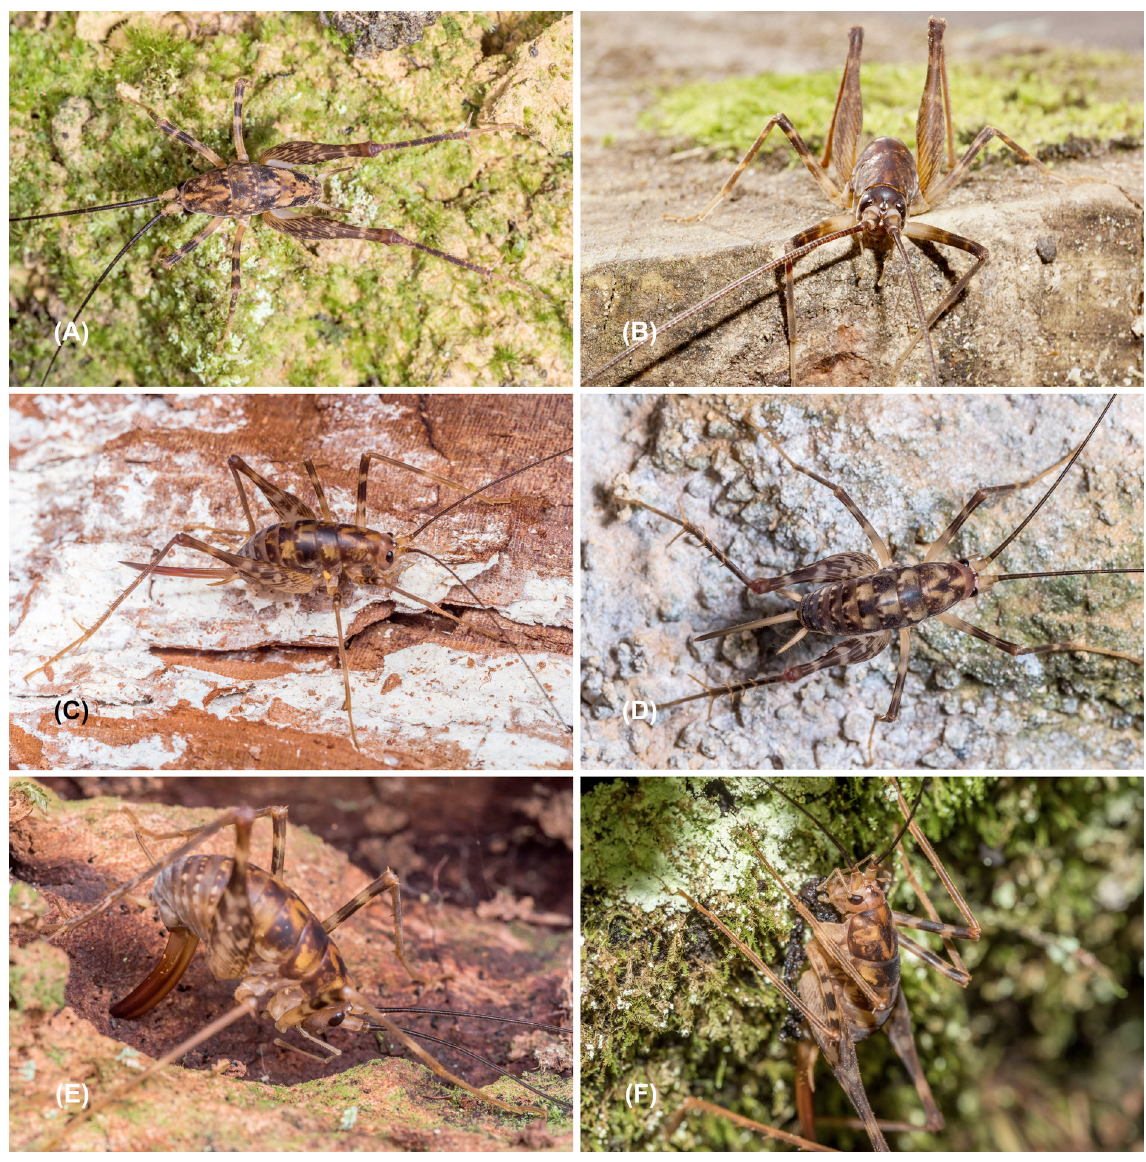
Fig. 10. Living Miotopus hutton, 1898 in their natural environment. A–B . Miotopus diversus